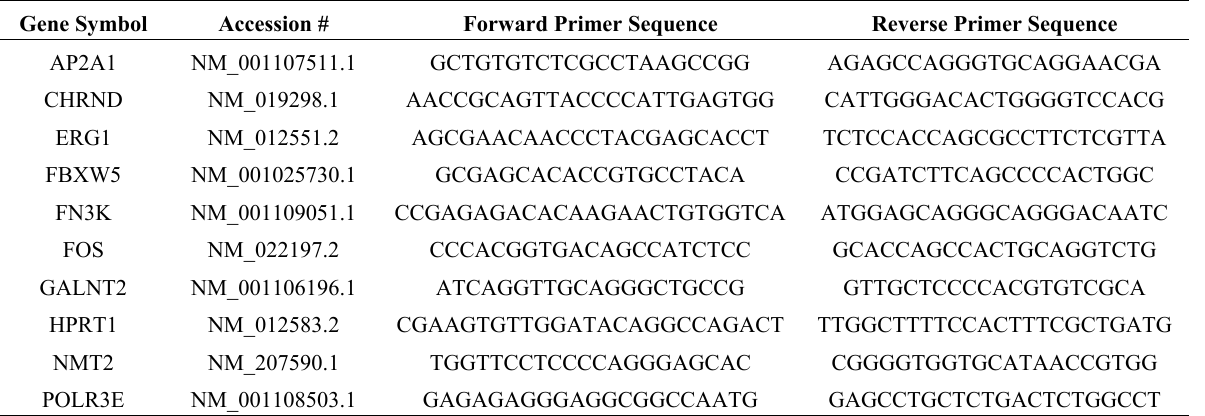
Table 1. Primer sequences used in